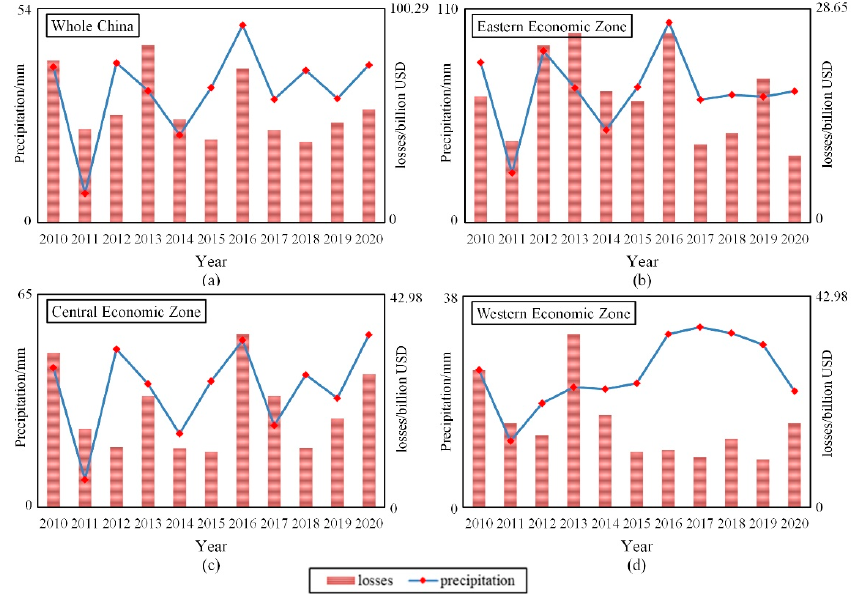
Figure 6. The distributions of monthly average precipitation (red bar) and natural disaster losses (blue line) each year in the period 2010–2020. Table 3. The correlation coefficient between monthly average precipitation and natural disaster losses in each region.